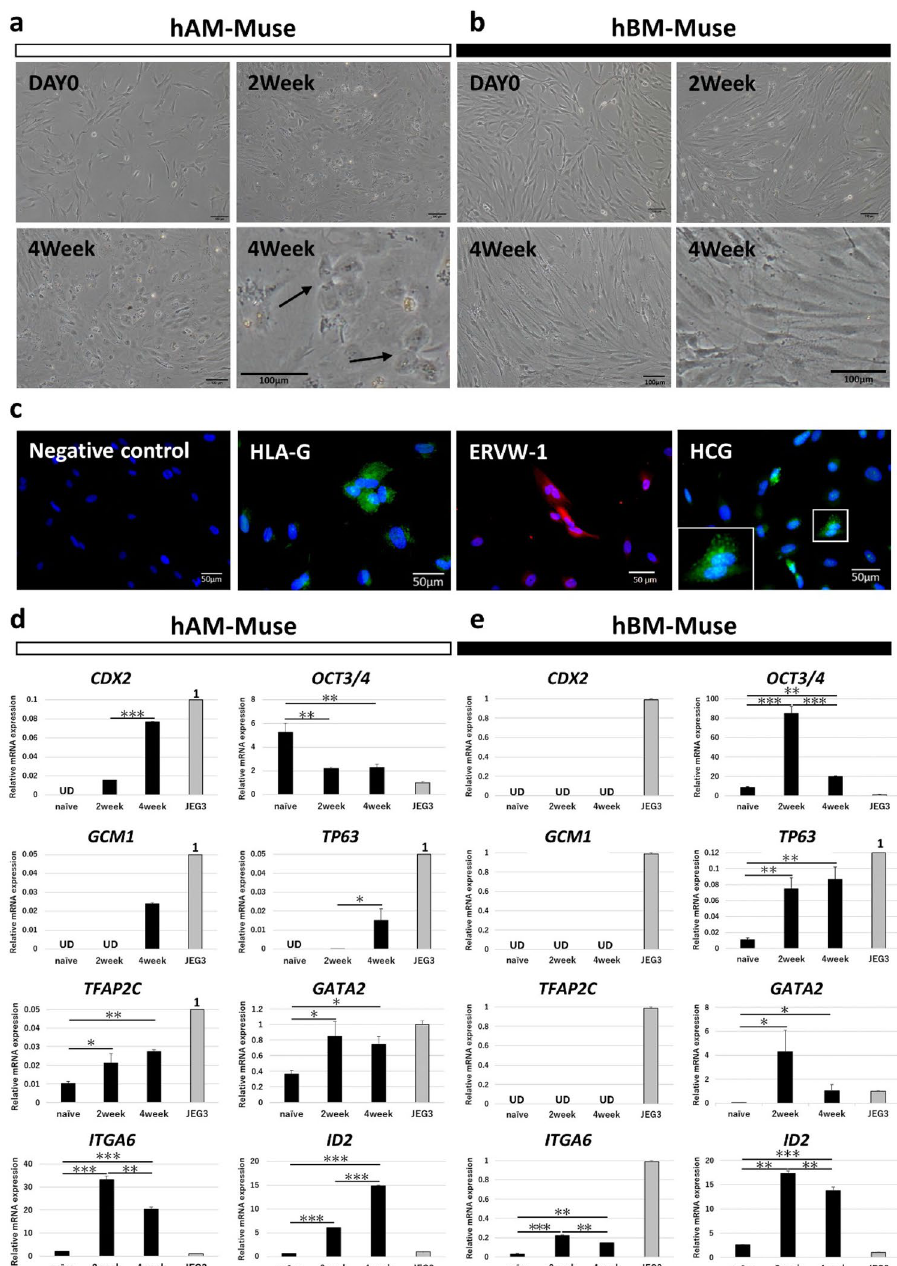
Figure 5. In vitro differentiation of hAM-Muse cells into extraembryonic-marker (+) cells. ( a , b ) Extraembryonic-lineage induction of hAM- ( a ) and hBM-Muse cells ( b ). hAM-Muse cells at 4 weeks after induction (a) assumed a different morphology than naïve cells and exhibited fusion-like cells (arrows; bars = 100 µm). ( c ) Immunocytochemistry for extraembryonic-markers (HLA-G, ERVW-1, and HCG) in hAM- Muse cells at 4 weeks after induction (bars = 50 µm). In HCG, fusion of the two cells was observed (see high magnification). ( d , e ) Expression of extraembryonic-related genes in naïve hAM- ( d ) and hBM-Muse ( e ), 2 and 4 weeks after induction and in JEG3 (normalized by ACTB ). Values of JEG3 were set as 1. * p < 0.05; ** p < 0.01; *** p < 0.001; UD, under